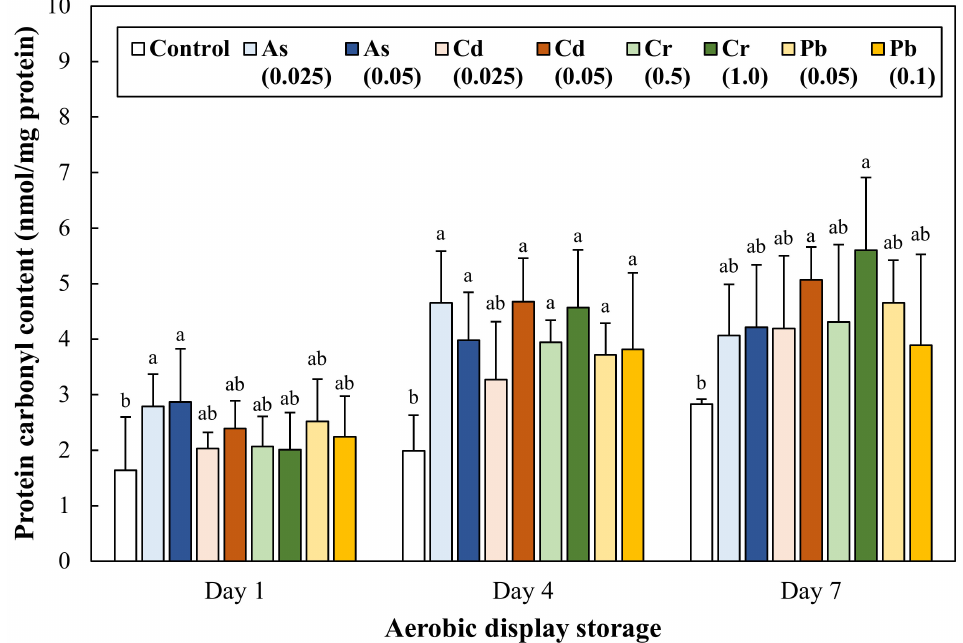
Figure 4. Change in protein carbonyl content of ground pork intentionally contaminated with toxic heavy metals during 7 days of aerobic display storage. The number in parentheses in legend indicates the target concentration (mg/kg) of each heavy metal in ground pork. Error bars represent each standard error (S.E.). The letters a, b represent results that are not significantly different from each other within each display storage ( p ≥